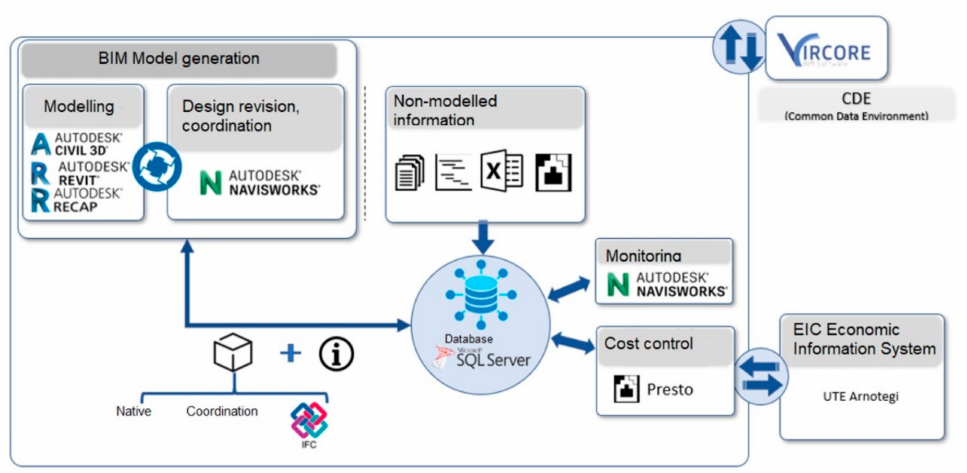
Figure 7. Collaborative work chart and references to software.